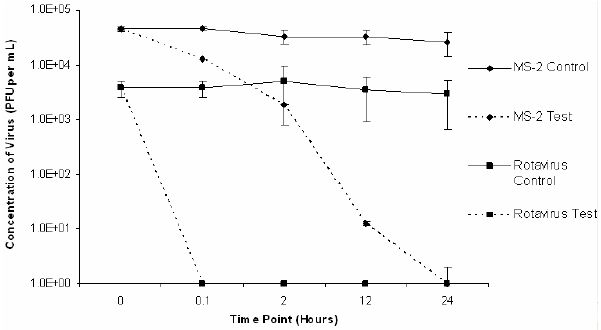
Figure 5: Average rotavirus Wa and MS2 inactivation in sludge matrices (compost, raw and previously limed) lime stabilized at reduced temperature (4 ±